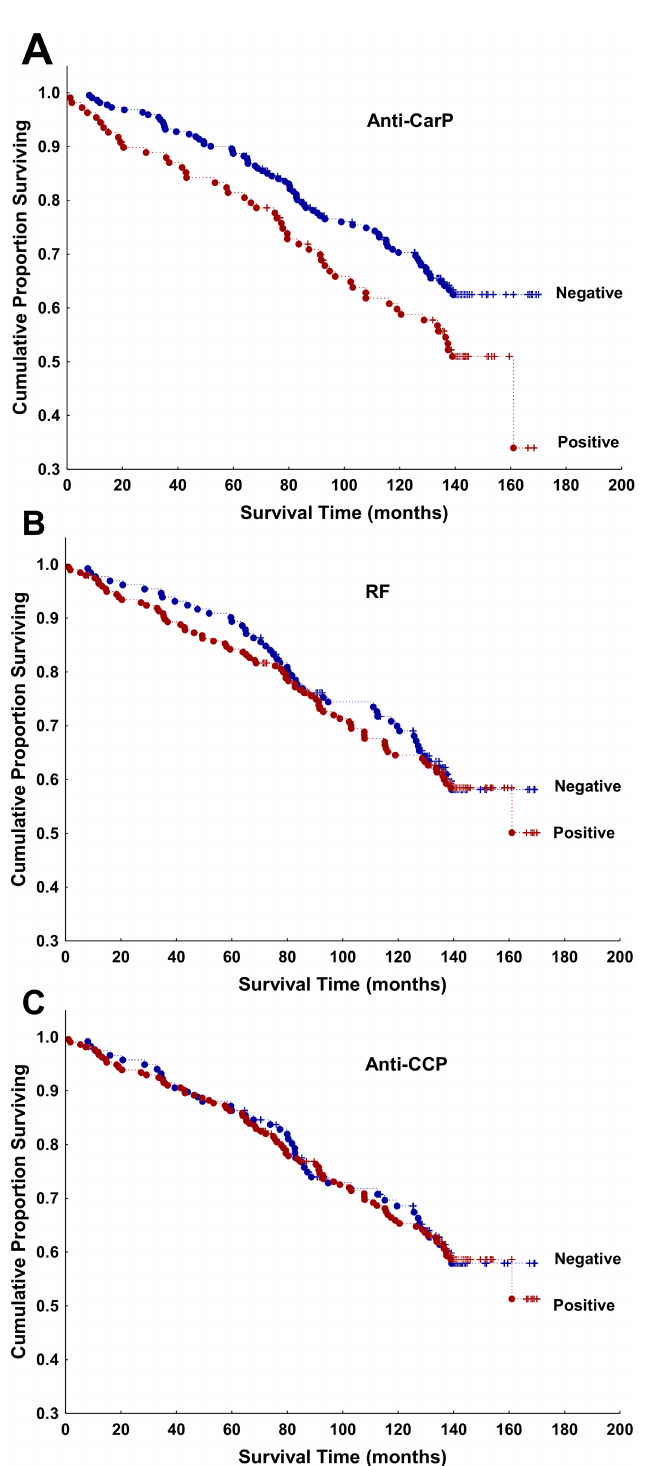
Fig 3. Kaplan-Meier survival curves of all patients with RA stratified by the status of the RA specific antibodies. (A) anti-CarP antibodies, (B) RF, and (C) anti-CCP antibodies. Red = antibodypositive, blue = antibody negative,dots = deaths, crosses = censoreddata. Note that these are unadjusted analyses.